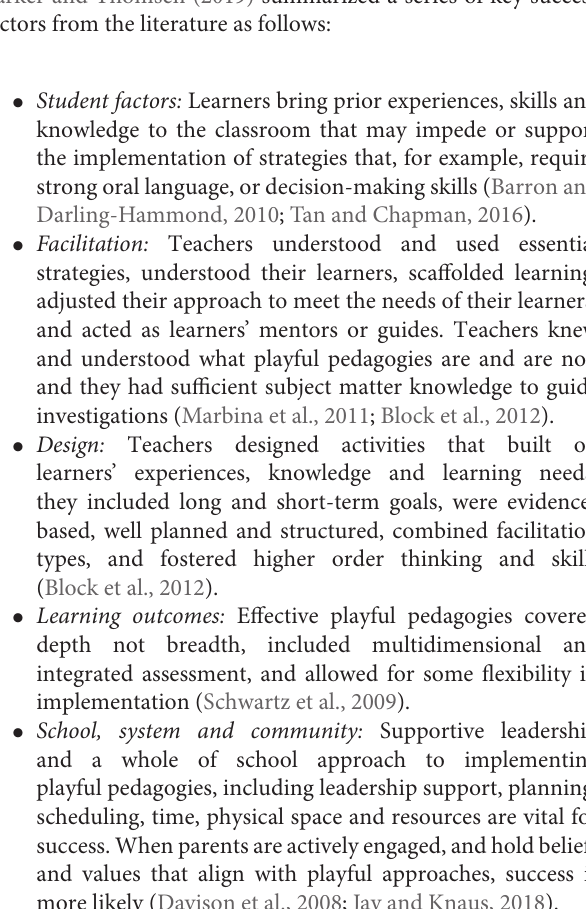
and describing the impact from peer reviewed empirical studies, making the review valuable to educators who use, plan to use, or plan to refine their practice regarding playful